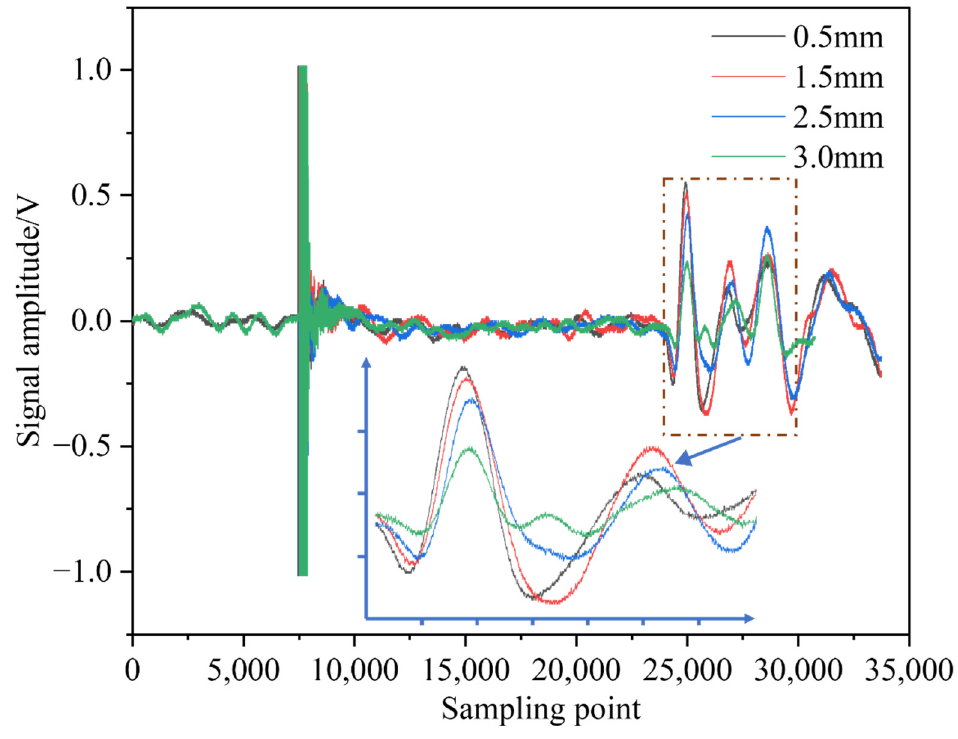
Figure 9. Experimental results with a 2.5 MHz center frequency detection transducer.